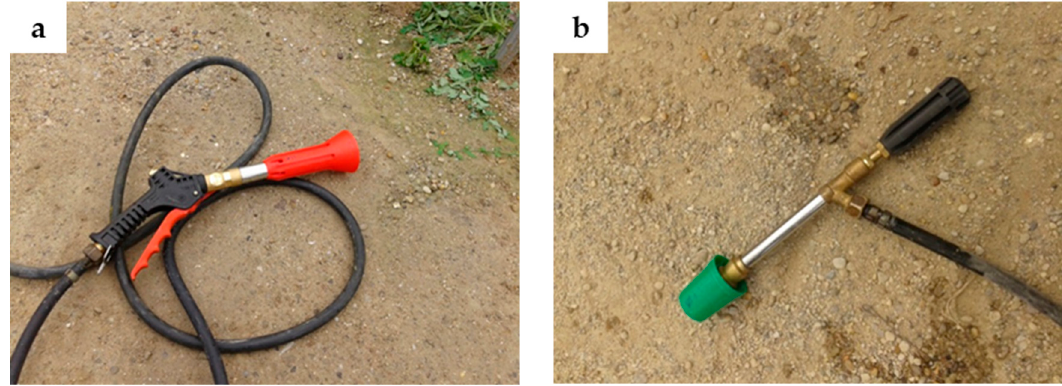
Figure 1. Trigger spray gun ( a ). Rotating-handle spray gun ( b ).